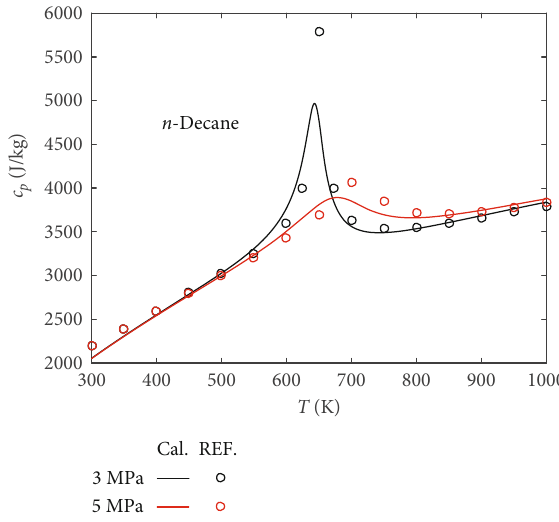
Figure 3: Comparison of constant-pressure speci fi c heat capacities of n -decane under di ff erent